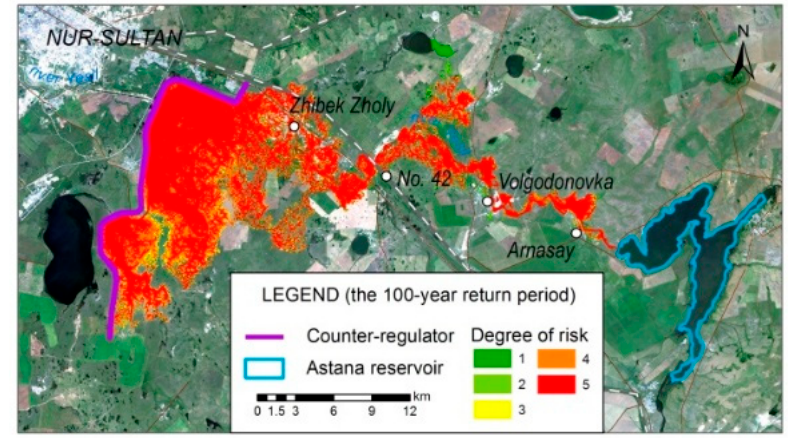
Figure 10. Hazard map (Classification 2) produced from the 100-year return period flow hydrograph.